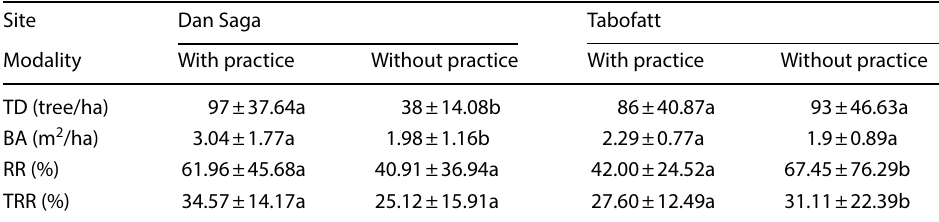
Table 2 vegetation structural and ecological values from Dan Saga and Tabofatt agroforestry parklands